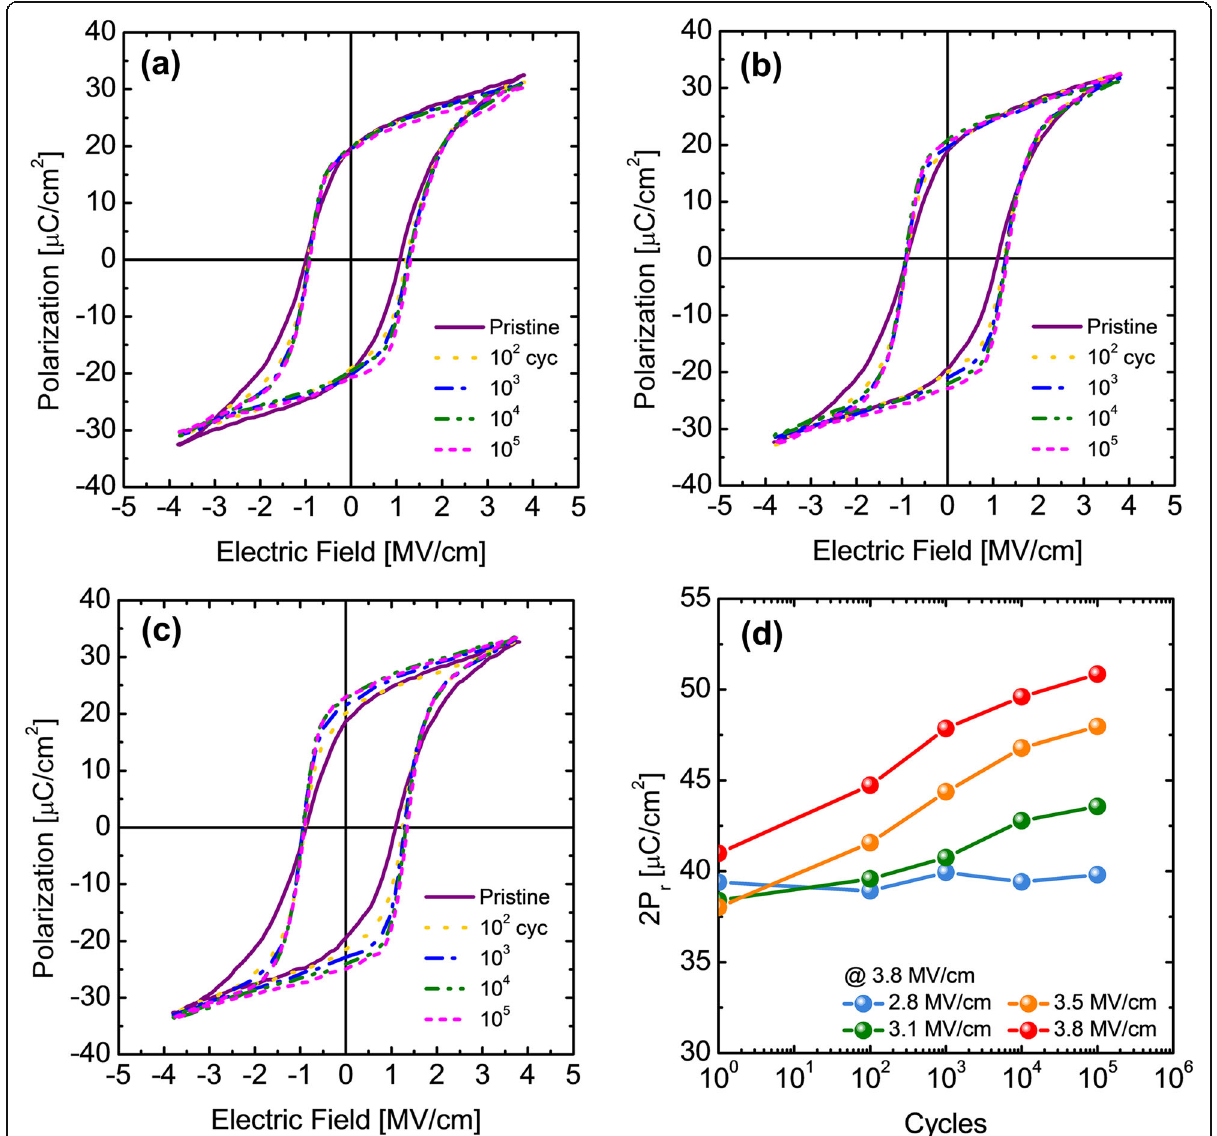
Fig. 4 The polarization – electric field (P – E) curves measured during wake-up test with the fatigue pulse height of ( a ) 2.8, ( b ) 3.1, and ( c ) 3.5 MV/ cm. ( d) The changes in 2P r value during the endurance test with 2.8, 3.1, 3.5, and 3.8 MV/cm-high fatigue